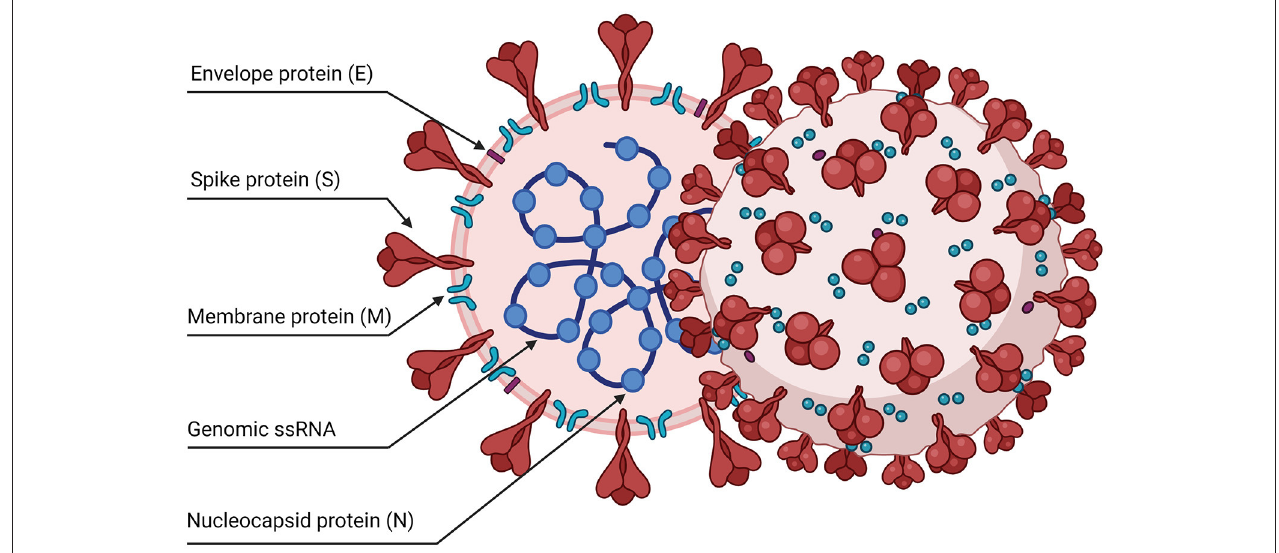
FIGURE 1 | Schematic representation of the SARS-CoV-2 viral particle. The virion contains a positive-sense, single-stranded RNA genome ( + ssRNA) enclosed by a lipidic envelope and by structural viral proteins. The nucleocapsid protein (N) is associated with the RNA genome inside the virus particles. Other proteins are inserted in the lipid envelope: the spike trimers (S), the envelope (E), and membrane (M) proteins.